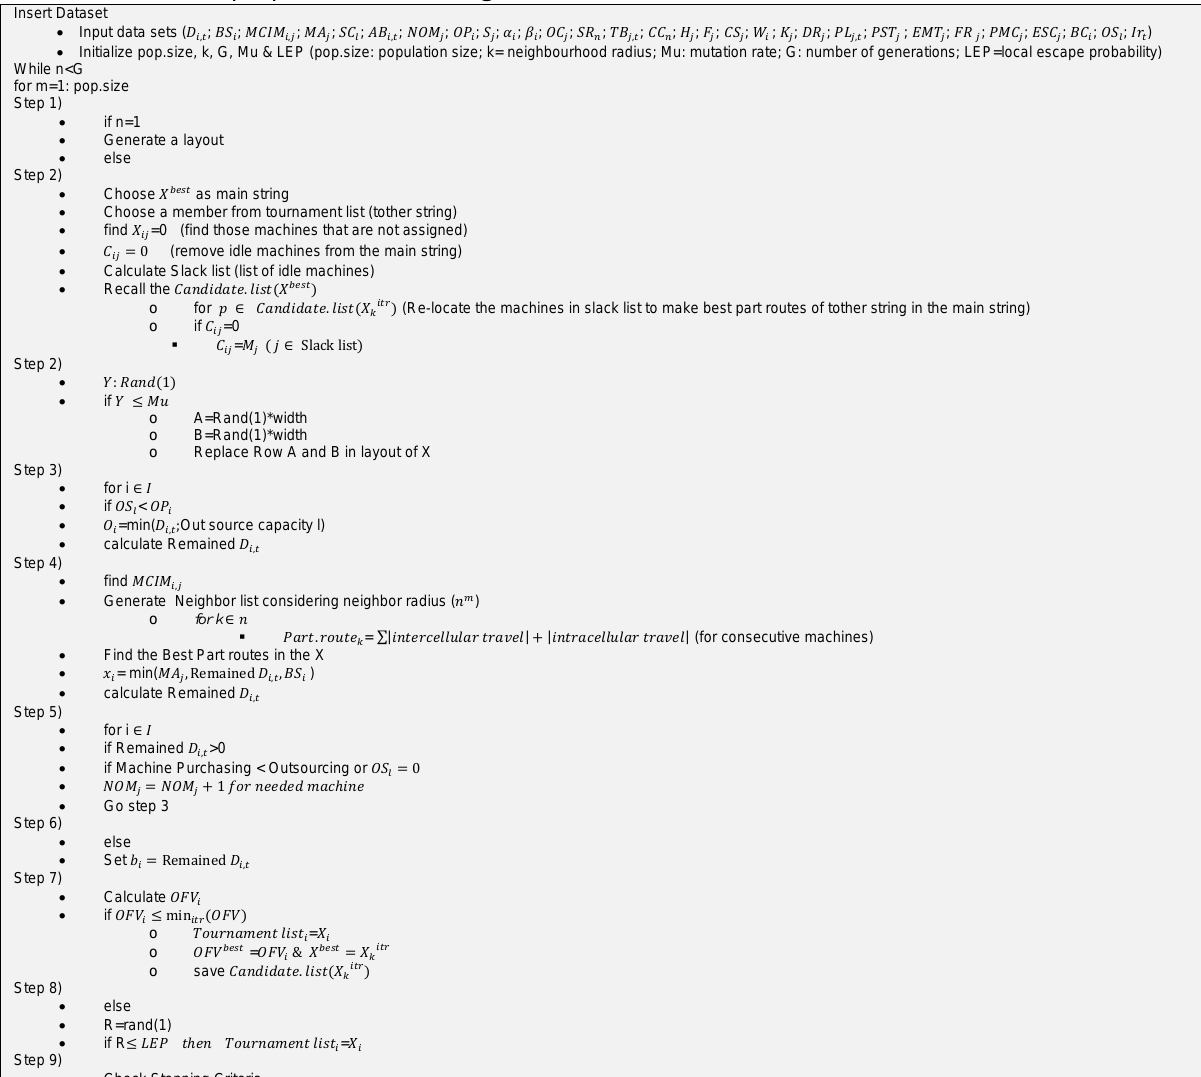
Pseudo code for the proposed Genetic